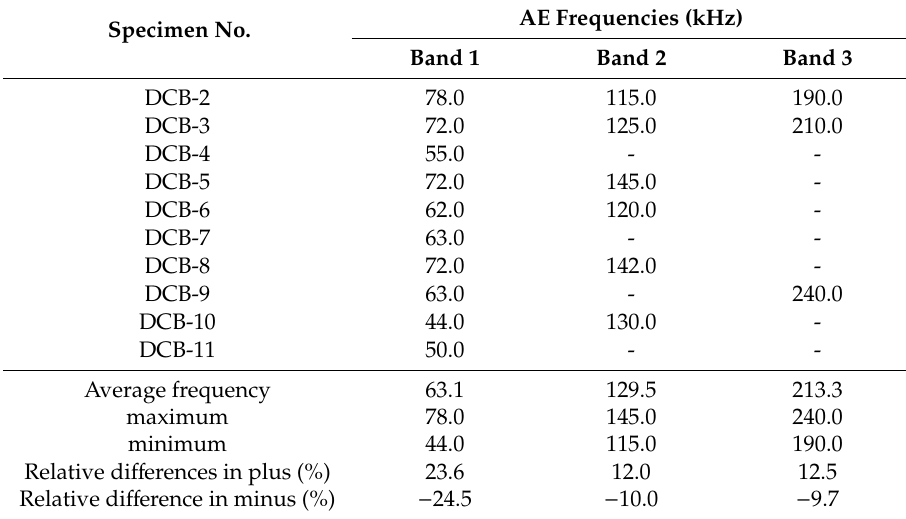
Table 3. Results of the fast Fourier transform (FFT) analysis of the raw Acoustic Emission (AE) signals recorded during the DCB